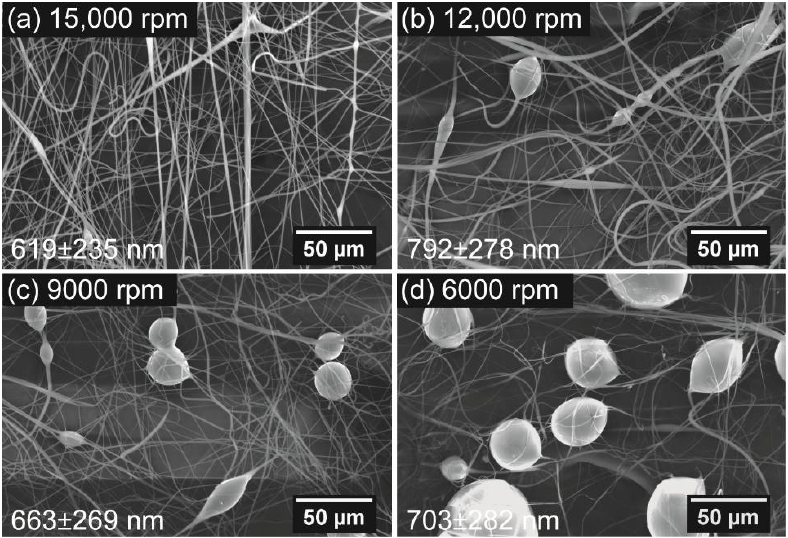
Figure 5. Scanning electron microscope images of centrifugally spun rPET fibers prepared under various rotation speeds: ( a ) 15,000; ( b ) 12,000; ( c ) 9000; and ( d ) 6000 rpm. Centrifugal spinning condition: polymer solution concentration, 10 wt %; needle inner diameter, 160 μm; collection distance, 10 cm.